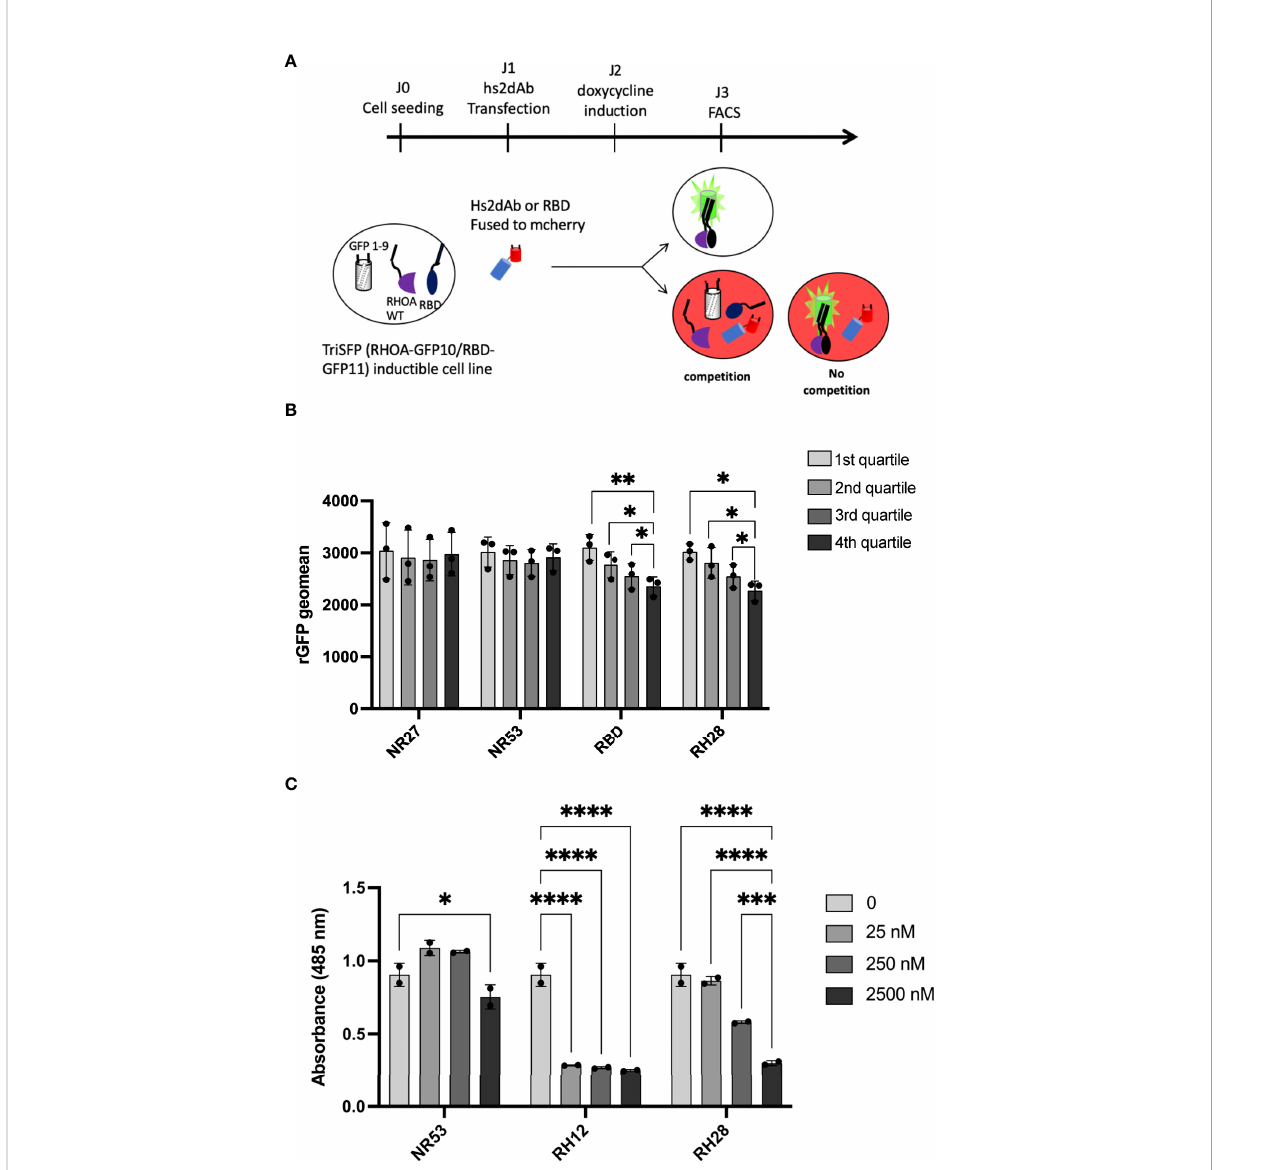
FIGURE 3 RH28 competes with RBD for active RHOA recognition. (A) Principle of the tripartite split-GFP complementation assay adapted to assess hs2dAb/RBD competition. Hs2dAb were transfected in the triSFP RHOA cell line, 24 hours before doxycycline induction. Among cells that express hs2dAb, a competition with RBD would lead to a decrease in the intensity of the rGFP fl uorescence in mCherry positive cells. (B) For each hs2dAb, rGFP fl uorescence intensity was quanti fi ed among the 4 different populations of mCherry positive cells (i.e., among the 4 cell populations ranked according to increasing levels of hs2dAb (or RBD) expression). (C) RHOA G-LISA competition assay with 10-fold dilutions of hs2dAb. Results were analyzed with two-way ANOVA model. Absorbance at 485 nm re fl ects RHOA-GTP captured by the coated RBD. P-values were calculated using a Student ’ s t test. *p < 0.05; **p < 0.01; ***p < 0.001; ****p <